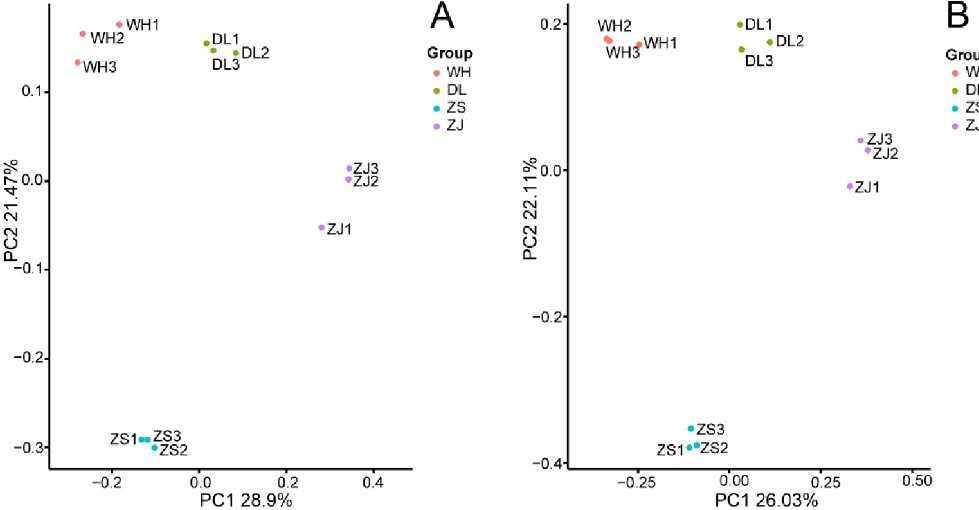
Fig 3. Comparison of the bacterial community structures in samples from different RPMs. Principal coordinates analysis (PCoA) based on the unweighted UniFrac distances (A) and binary Jaccard distances (B). PCoA analysis was performed with the OTUs (at 97% similarity) present in the RPM